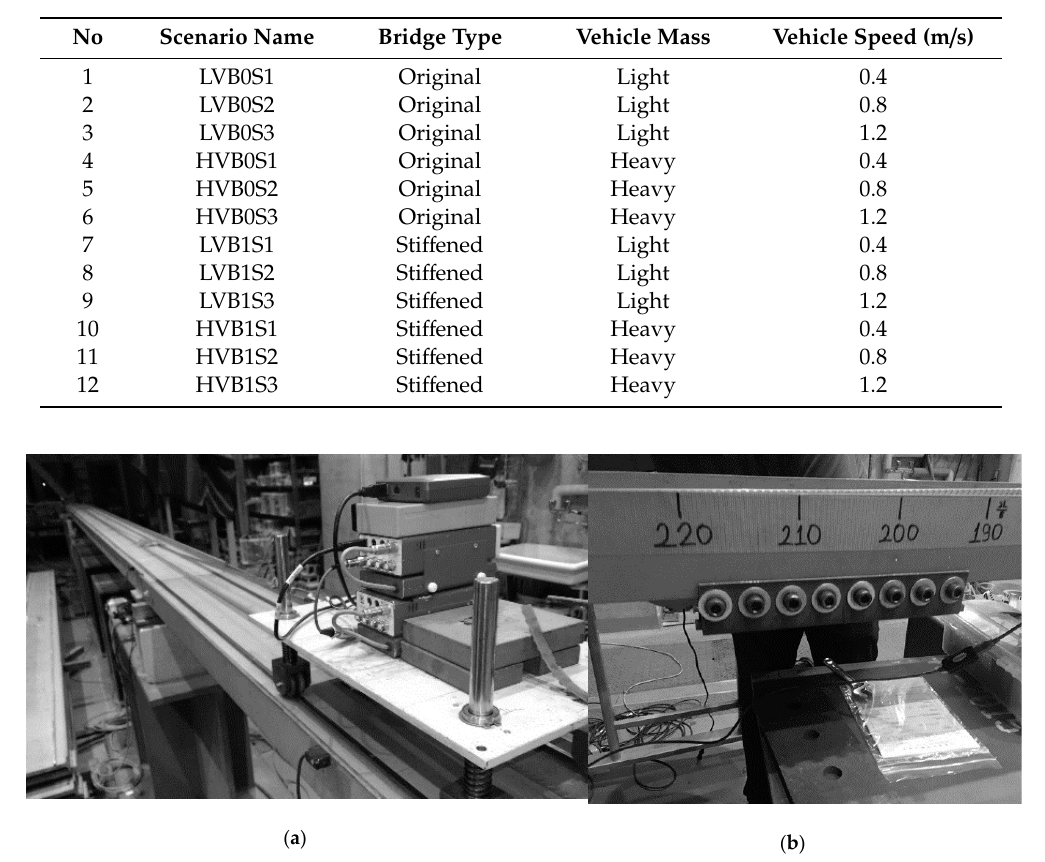
Figure 10. ( a ) General scheme of a small-scale bridge with passing vehicles; ( b ) cross-section of section A-A. Table 5. List for small scale bridge experiments.